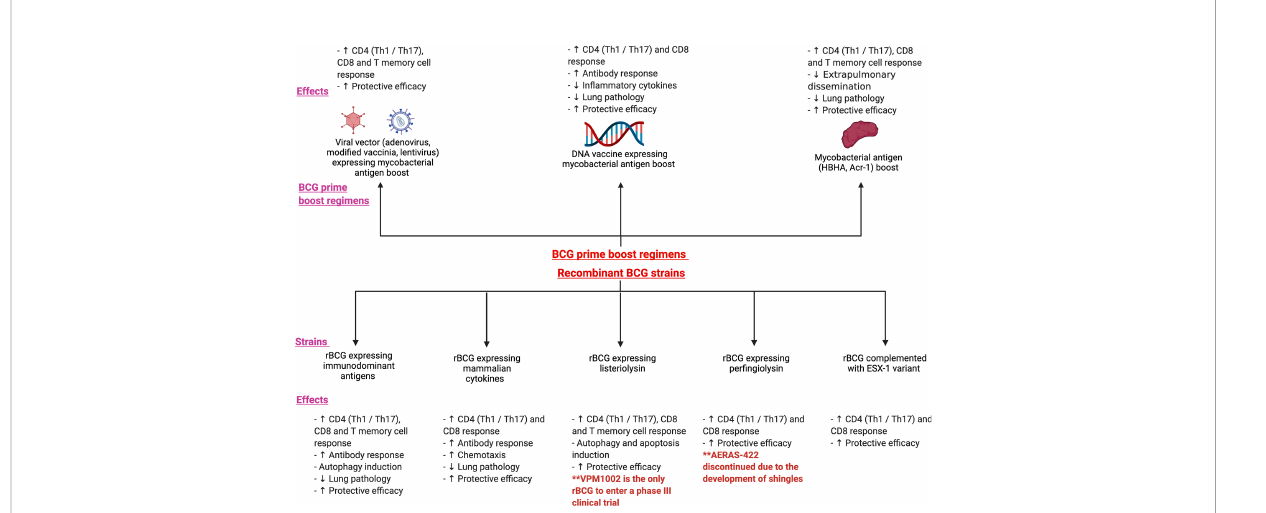
FIGURE 2 illustrates the various prime boost regimens and the recombinant BCG strains that have been investigated in both animal models and human studies. The fi gure shows the immunological and protective effects following 3 main BCG prime -boost regimens: viral vector expressing mycobacterial antigen boost, DNA vaccine expressing mycobacterial antigen boost and mycobacterial antigen boost. The bottom panel of the fi gure depicts the various recombinant strains such as recombinant BCG expressing immunodominant antigens, mammalian cytokines, listeriolysin, per fi ngiolysin and the ESX-1 variant. Their immunological and protective effects have also been